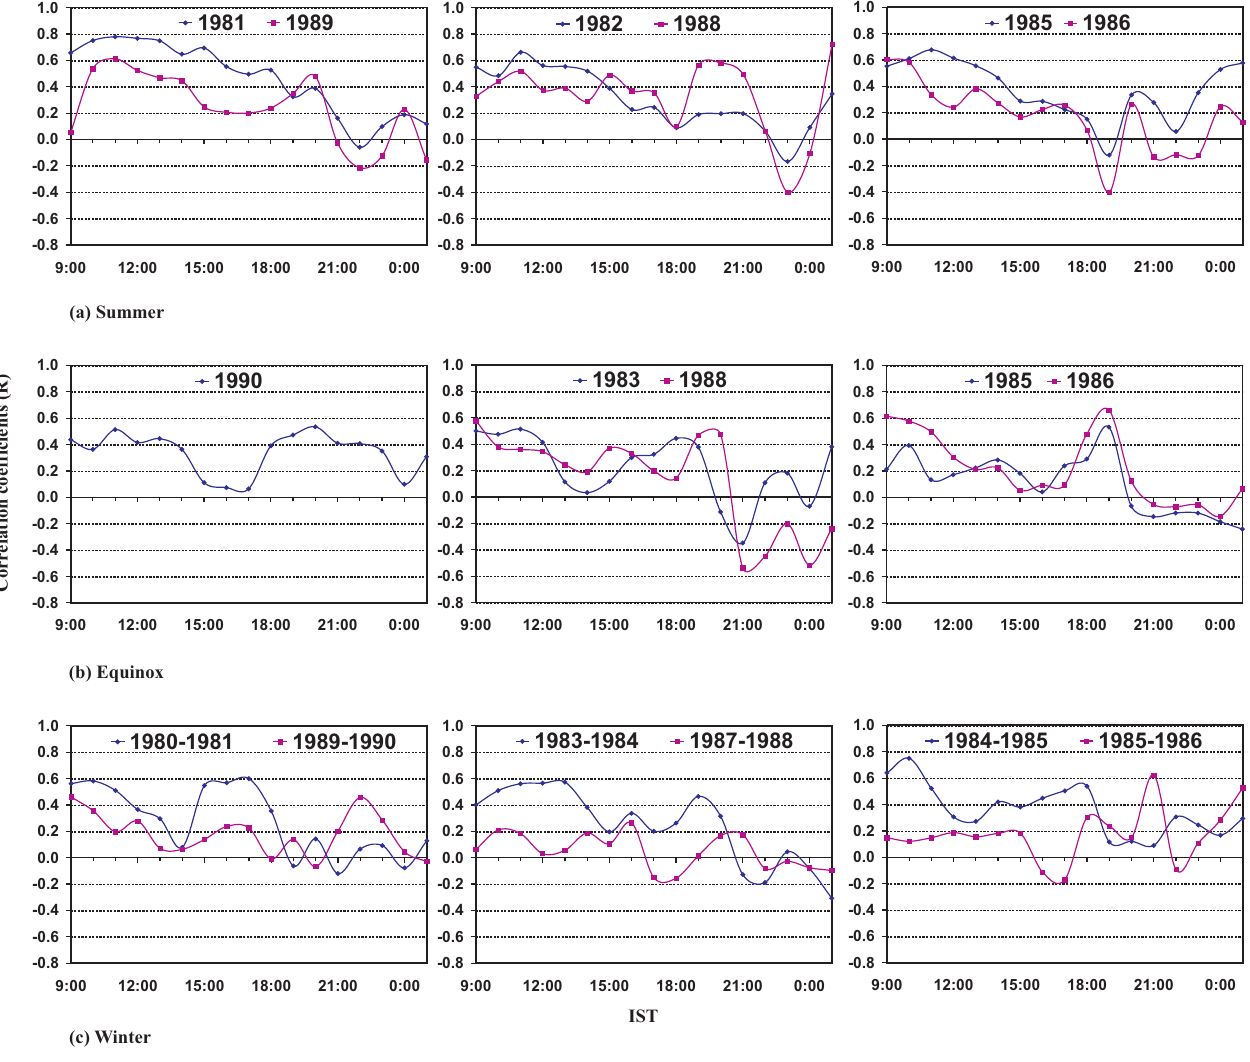
Figure. 2 Fig. 2. Diurnal variation of correlation coefficients ( R ) between TEC ( t h) and EEJ strength ( t − 2h) calculated on the basis of Fig. 1 for high to summer solstitial months, (b) refers to equinoctial months and (c) corresponds to winter solstitial months. TEC data for the equinoctial months of high solar activity period of descending phase (1980–1985) are incomplete due to irregular satellite (ETS-2)